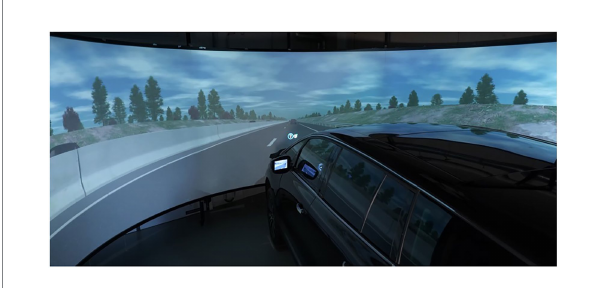
FIGURE 1 Driving simulator composed of a car with a 180 ° field of view. Adapted/Reproduced with permission from IRT